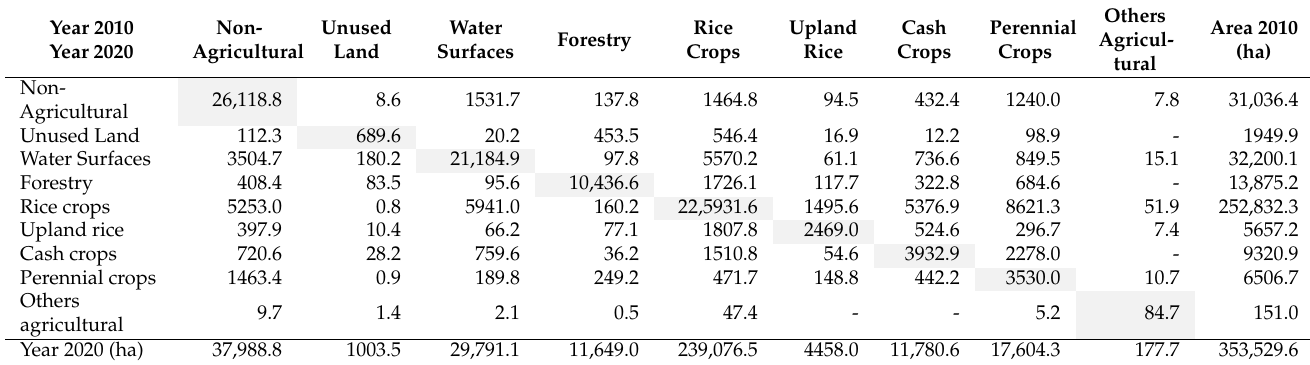
Table 5. Land use change matrix for the period of 2010–2020 in An Giang